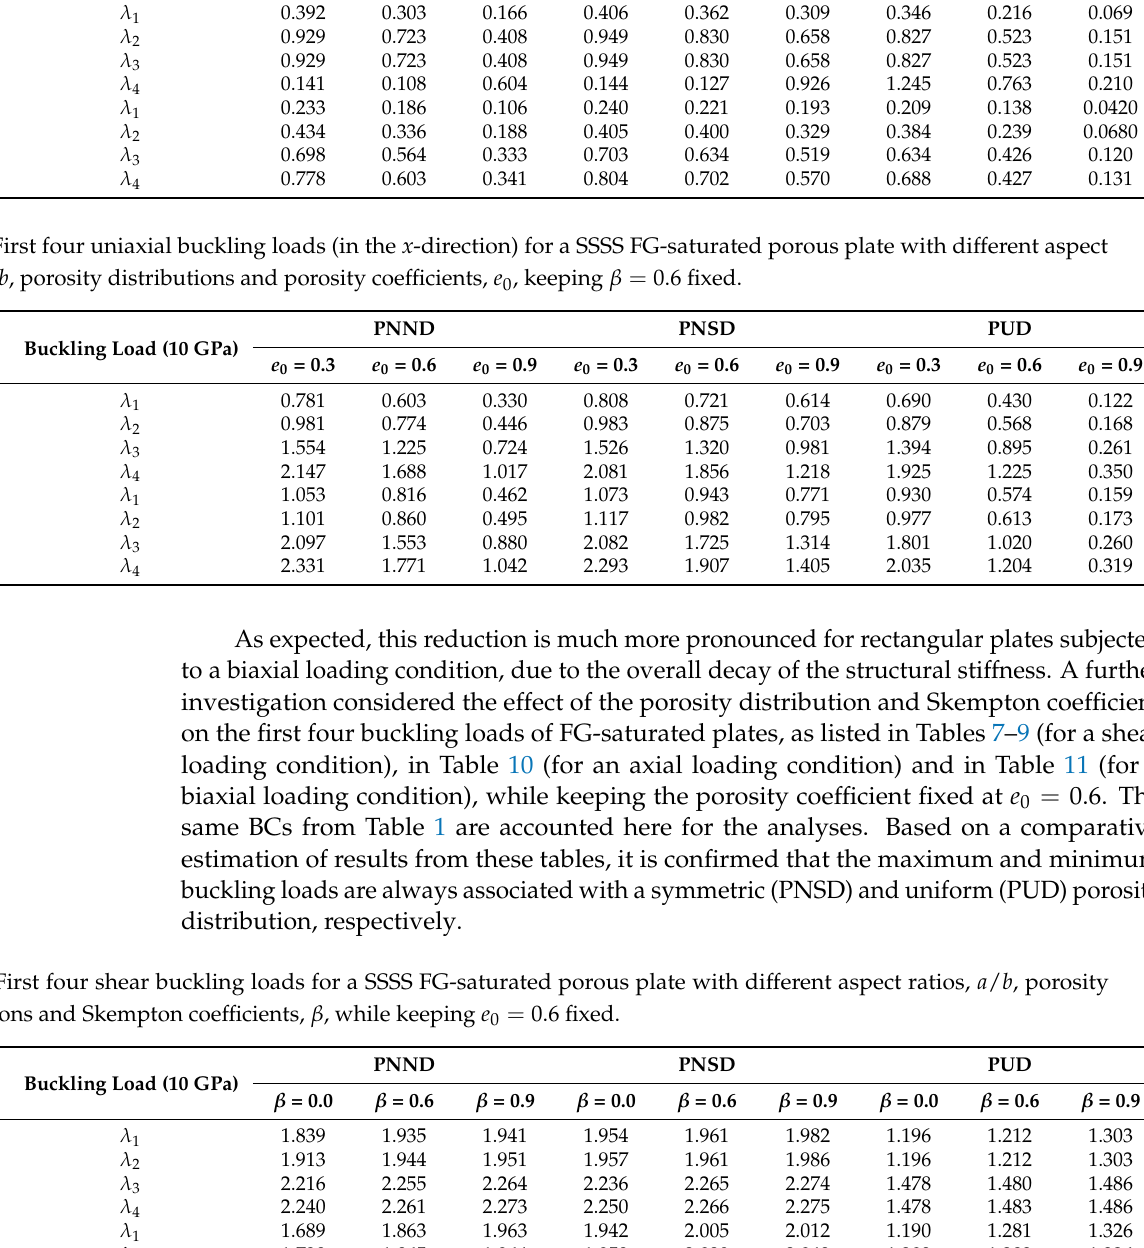
Table 5. First four biaxial buckling loads for a SSSS FG-saturated porous plate with different aspect ratios, a / b , porosity distributions and porosity coefficients, e 0 , keeping β = 0.6 fixed. Aspect Ratio